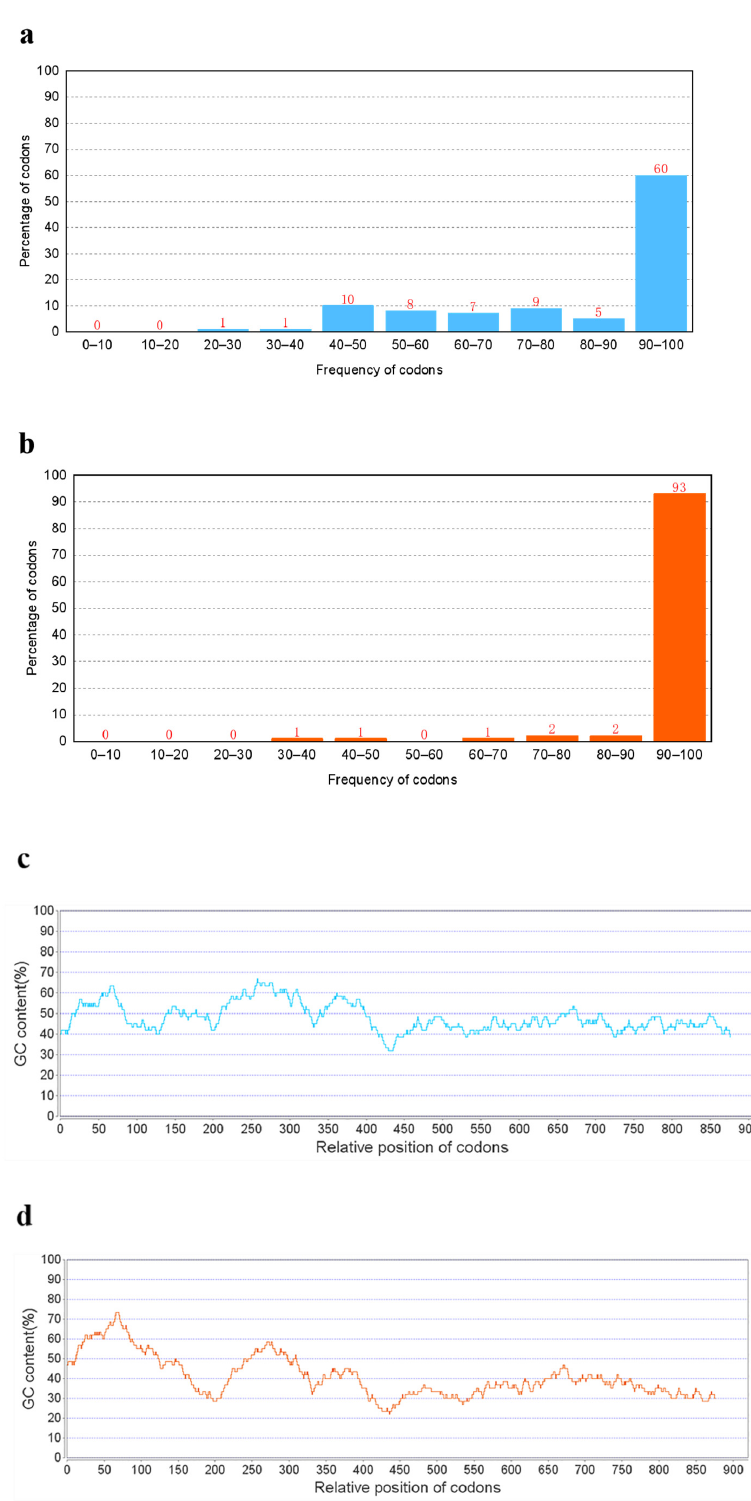
Figure 2. ( a ) Original sequence. ( b ) Optimized sequence. Frequency of optimal codons. Shows the percentage distribution of codons; codons with a higher percentage are more frequently used. ( c ) Original Sequence (47.1%). ( d ) Optimized sequence (40.3%). GC content adjustment. The ideal percentage range of GC content is between 30% and 70%, ideally